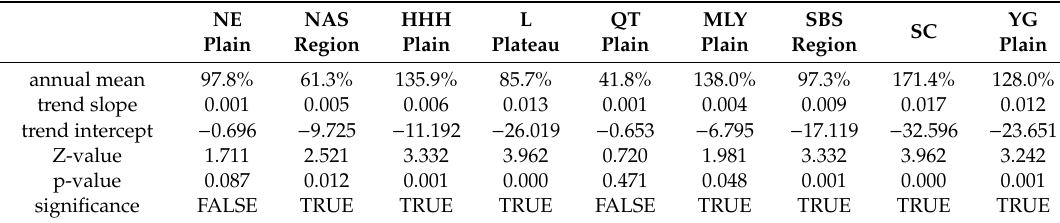
Figure 3. Changes in the mean cropping intensity for nine individual agricultural zones in China in 2001–2016. Table 2. Brief summary for the statistics associated with the annual mean cropping intensity in 2001–2016 and its changing trend. Trend slope and intercept denote the linear trend of the annual mean cropping intensity changes in 2001–2016. Z- value, p-value and significance denote the Mann–Kendall tests applied to the trend of annual mean cropping intensity changes in 2001 – 2016.